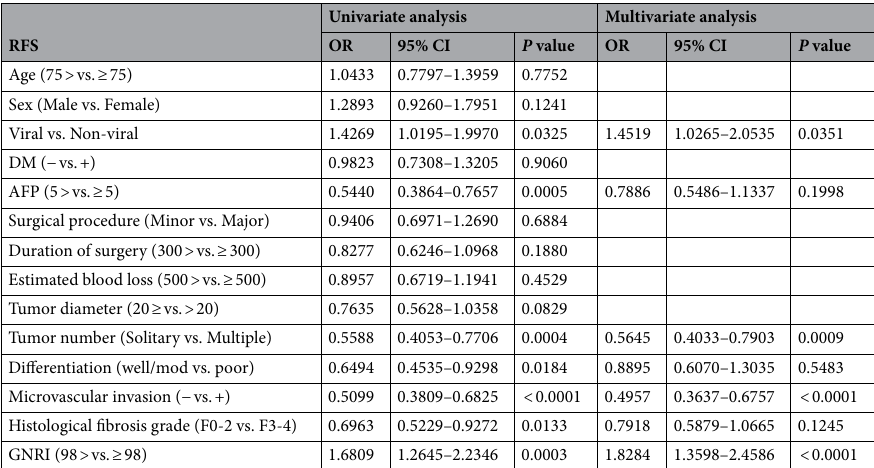
Table 2. Univariate and multivariate analyses of recurrence-free survival. AFP: alpha-fetoprotein, CI: confidence interval, DM: diabetes mellitus, GNRI: geriatric nutritional risk index, OR: odds ratio, RFS: recurrence-free